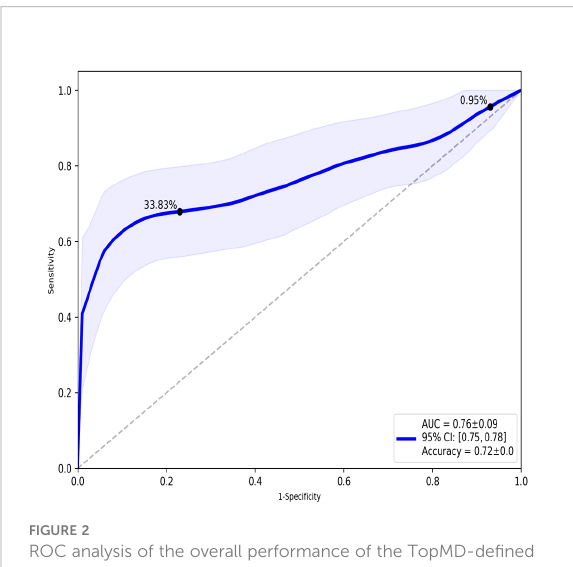
FIGURE 1 The importance of genes in a classi fi cation of ICU admission with Random Forest. The higher the value of importance of the variable (mean decrease gini score), the higher the importance of the gene(s) in the model.